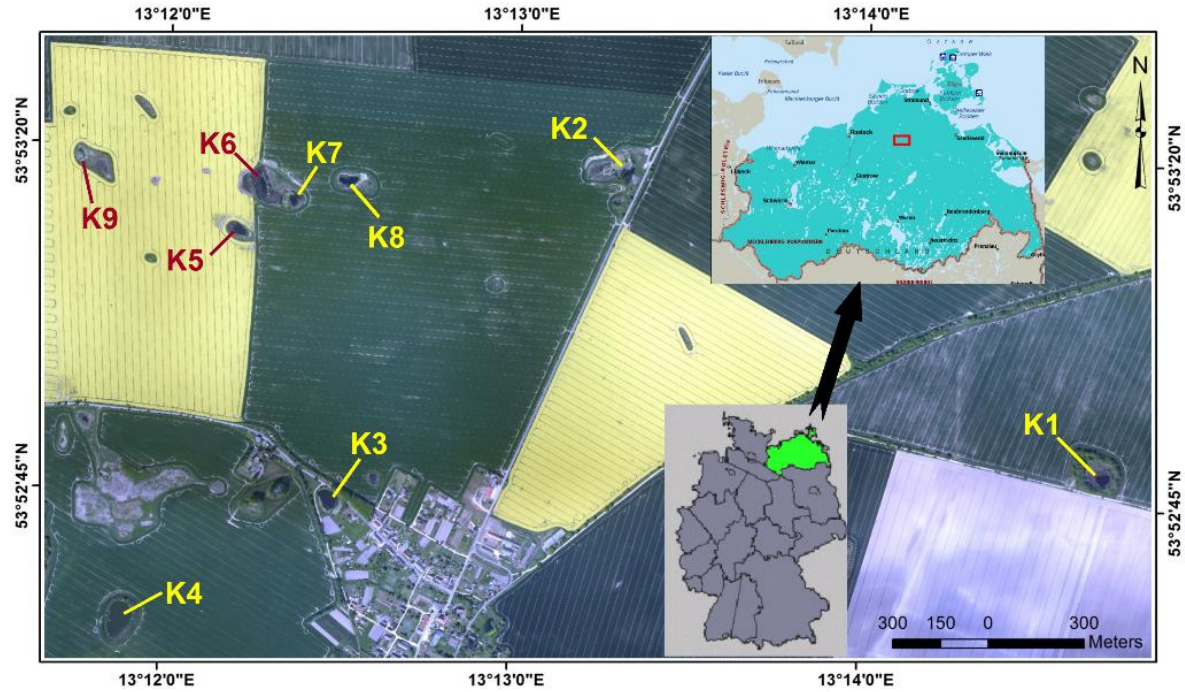
Figure 1. True color composite image (15 May 2008) of test area (close to the village Schmarsow, Demmin suburbs, Germany) with kettle holes